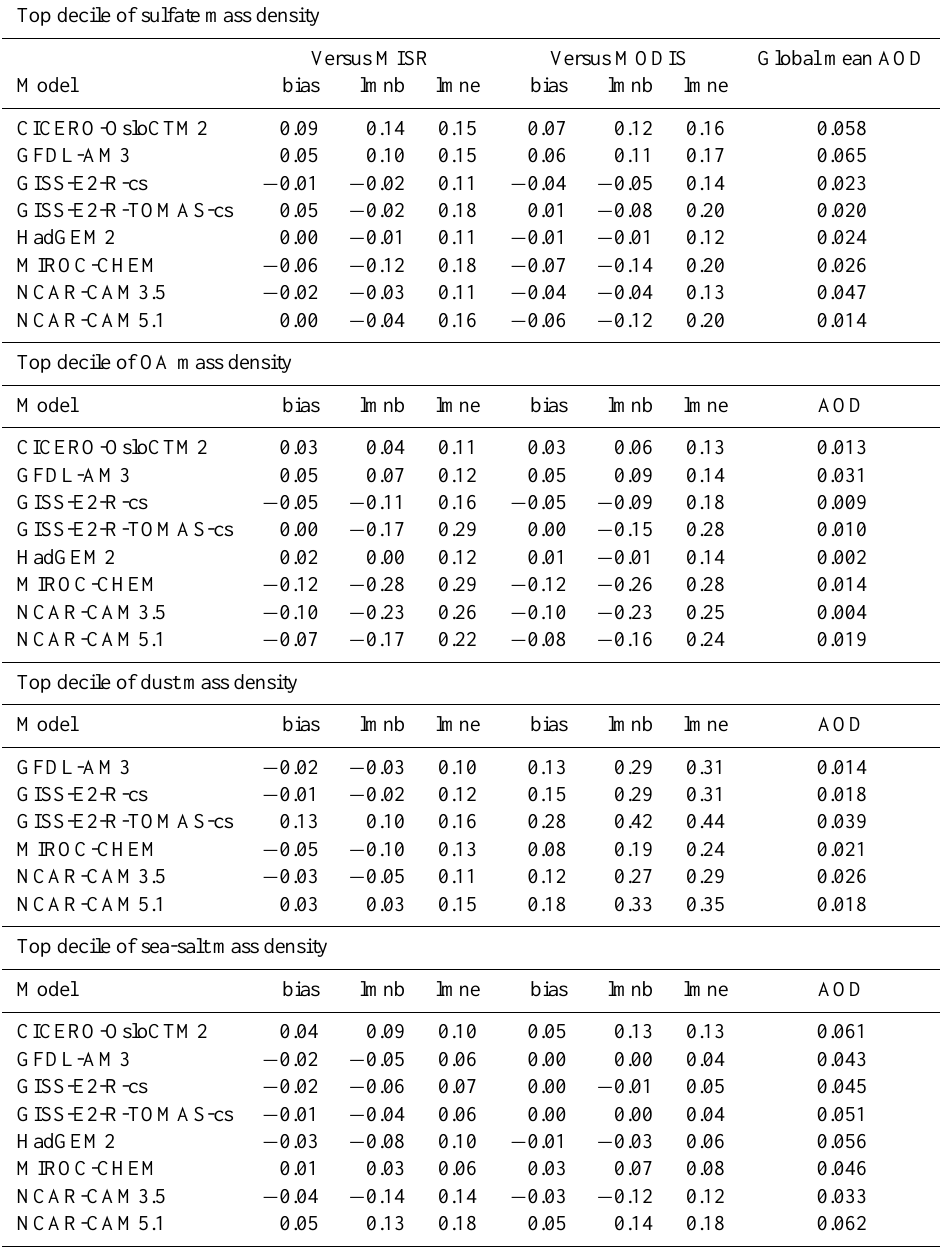
Table 4. Evaluation of model AOD in comparison with satellite observations sorted by locations dominated by sulfate, OA, dust and sea-salt. Top decile of sulfate mass density Versus MISR Versus MODIS Global mean AOD Model bias